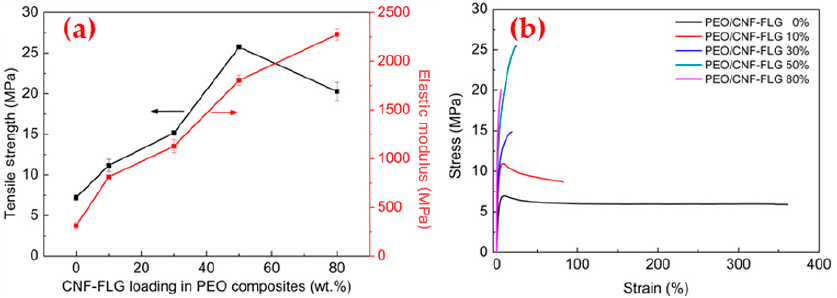
Figure 5. ( a ) Tensile strength and Young’s modulus of PEO/CNFs-FLG nanocomposite films; ( b ) Stress-strain curves of PEO/CNFs-FLG nanocomposite films.